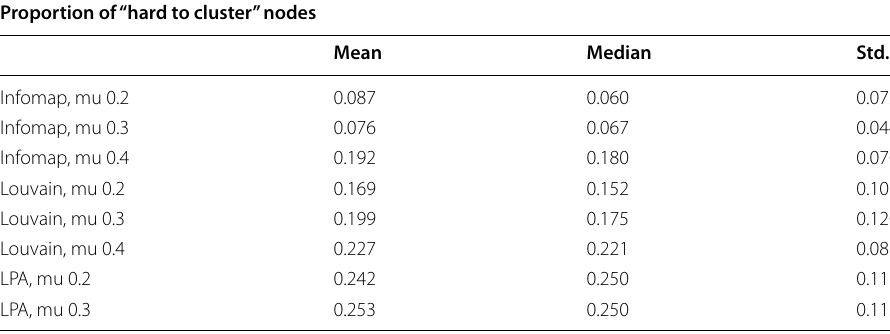
algorithm on graphs of varying µ